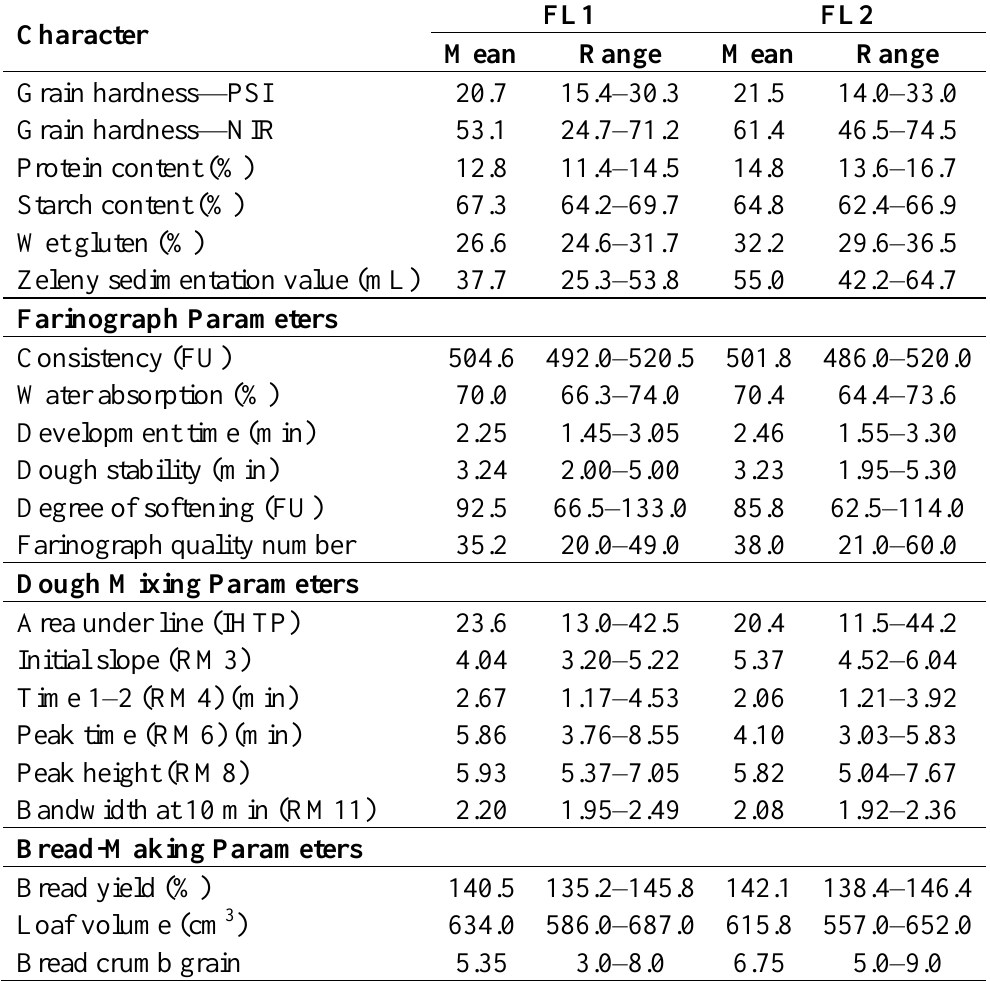
Table 2. Mean values and ranges for grain hardness and wheat quality characteristics of wheat lines assessed at two fertilization levels ( FL1 , FL2 ).